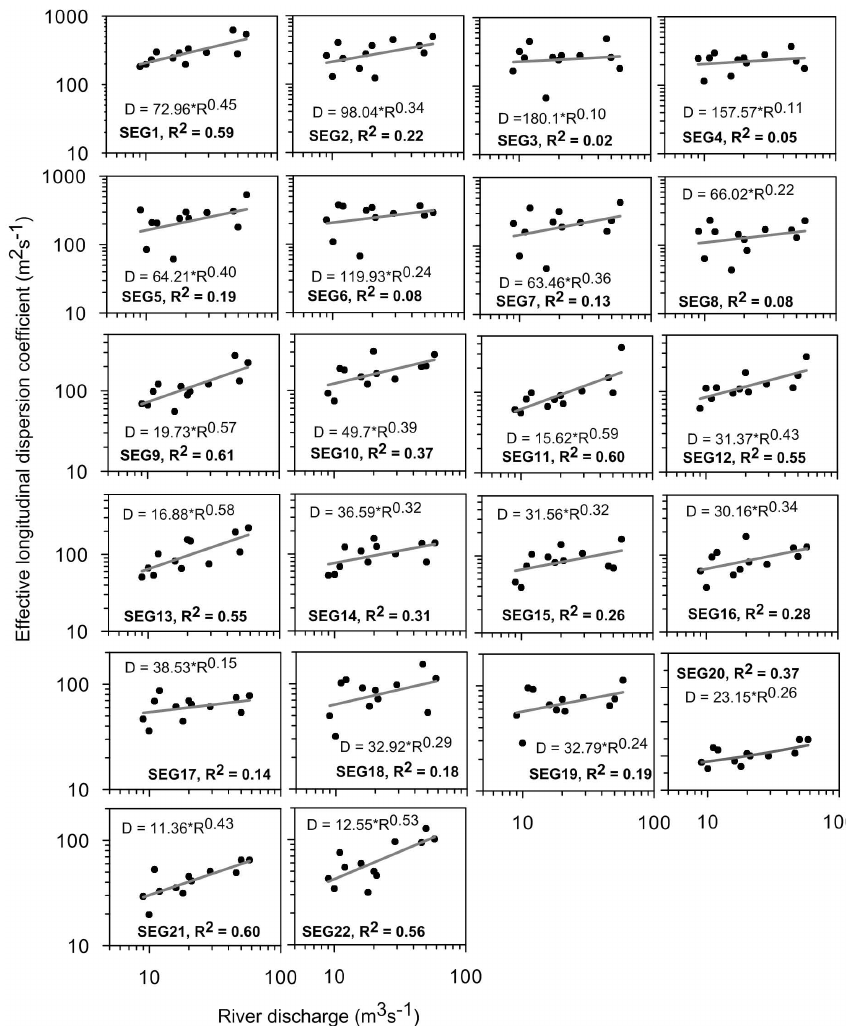
Fig. 5. Effective longitudinal dispersion coefficient ( D ) estimated at high water slack versus river discharge ( R ) at various positions along the Sumjin River